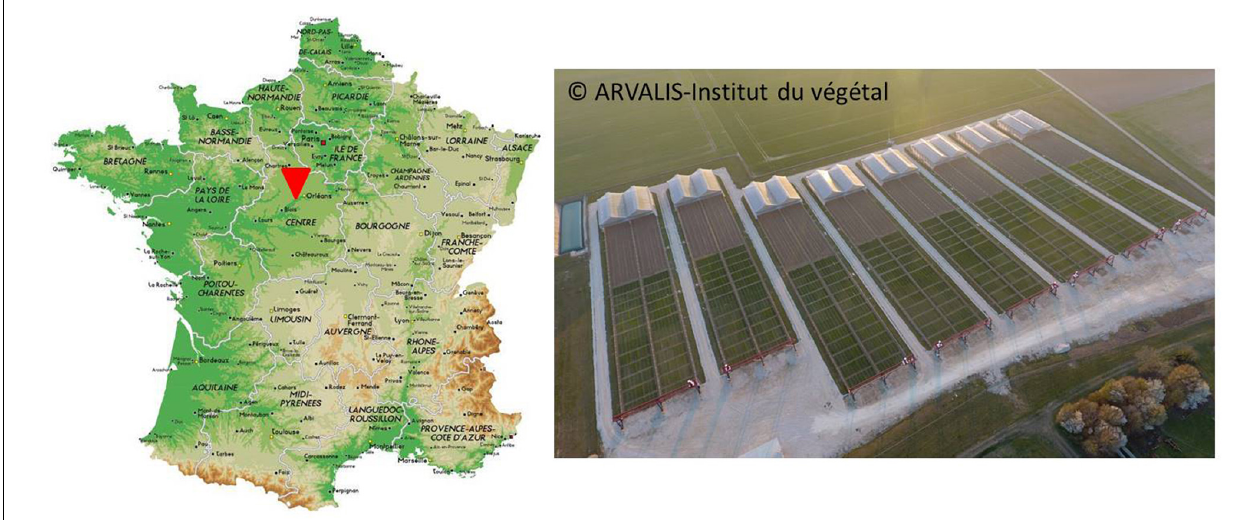
FIGURE 1 | Location of PhénoField R (cid:13) platform in France, near Orléans, and aerial view of the 8 rainout shelters and gantries around wheat field trial ( GPS coordinates: 47 ◦ 53 (cid:48) 01.6 (cid:48)(cid:48) N 1 ◦ 31 (cid:48) 16.4 (cid:48)(cid:48) E ).